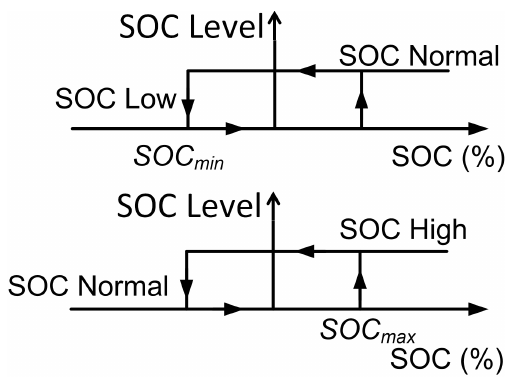
Figure 6. Hysteresis control.